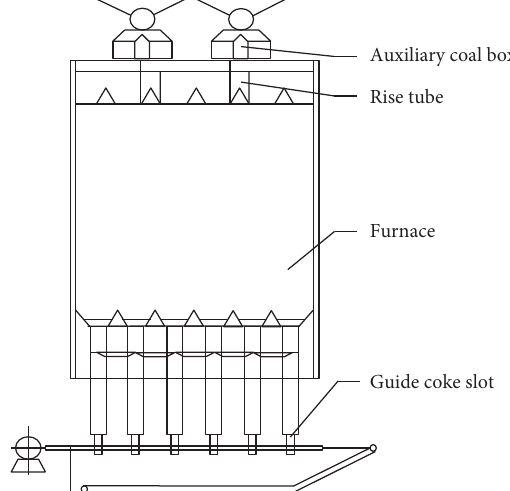
Figure 2: Schematic diagram of the structure of SJ-type internal heat low-temperature dry distillation furnace.